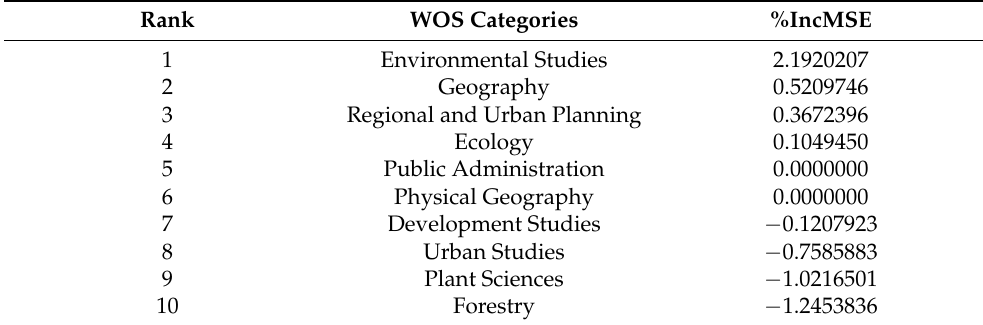
Table 10. Impactors’ rank (WOS categories).